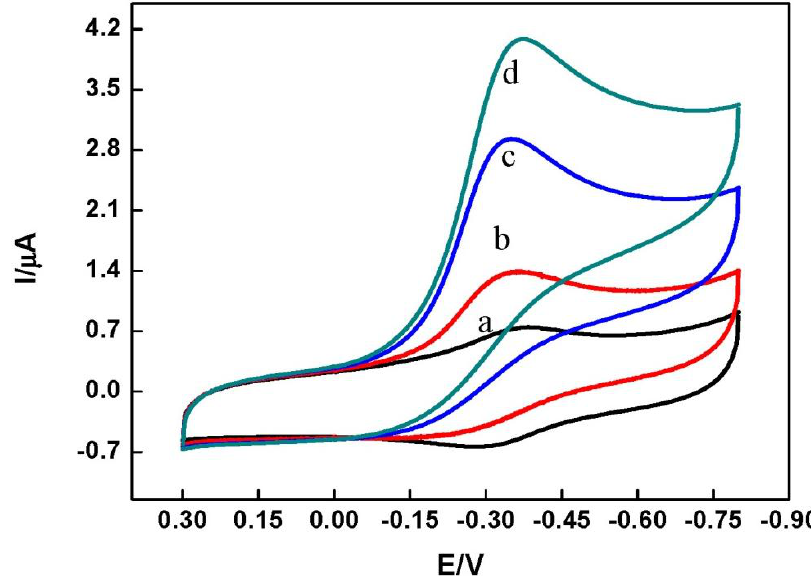
Figure 6. Cyclic voltammograms of DNA/chitosan/Fe phosphate buffer solution (pH 7.0) in the presence of various H ( b ) 1 mM; ( c ) 3 mM; ( d ) 4